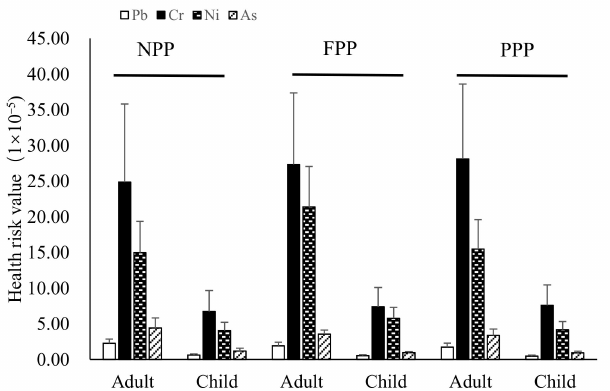
Figure 4. Cancer risks of Pb, Cr, Ni, and As from ingestion pathways in the water from the different subsidence ponds (only Pb × 10 − 7